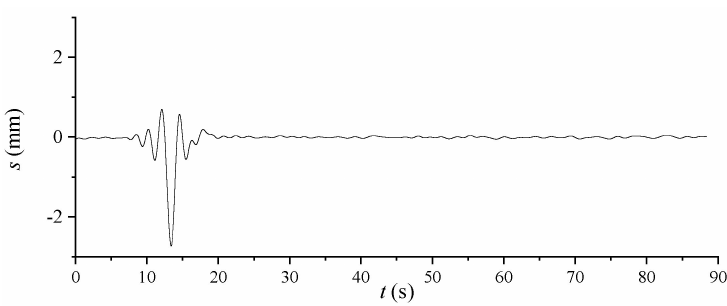
Figure 10. Mid-span displacement signal after filtering at a speed of 20 km/h.